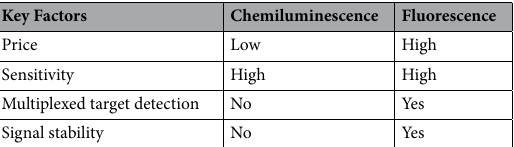
Table 1. Key comparative factors between chemiluminescence and fluorescence detection.